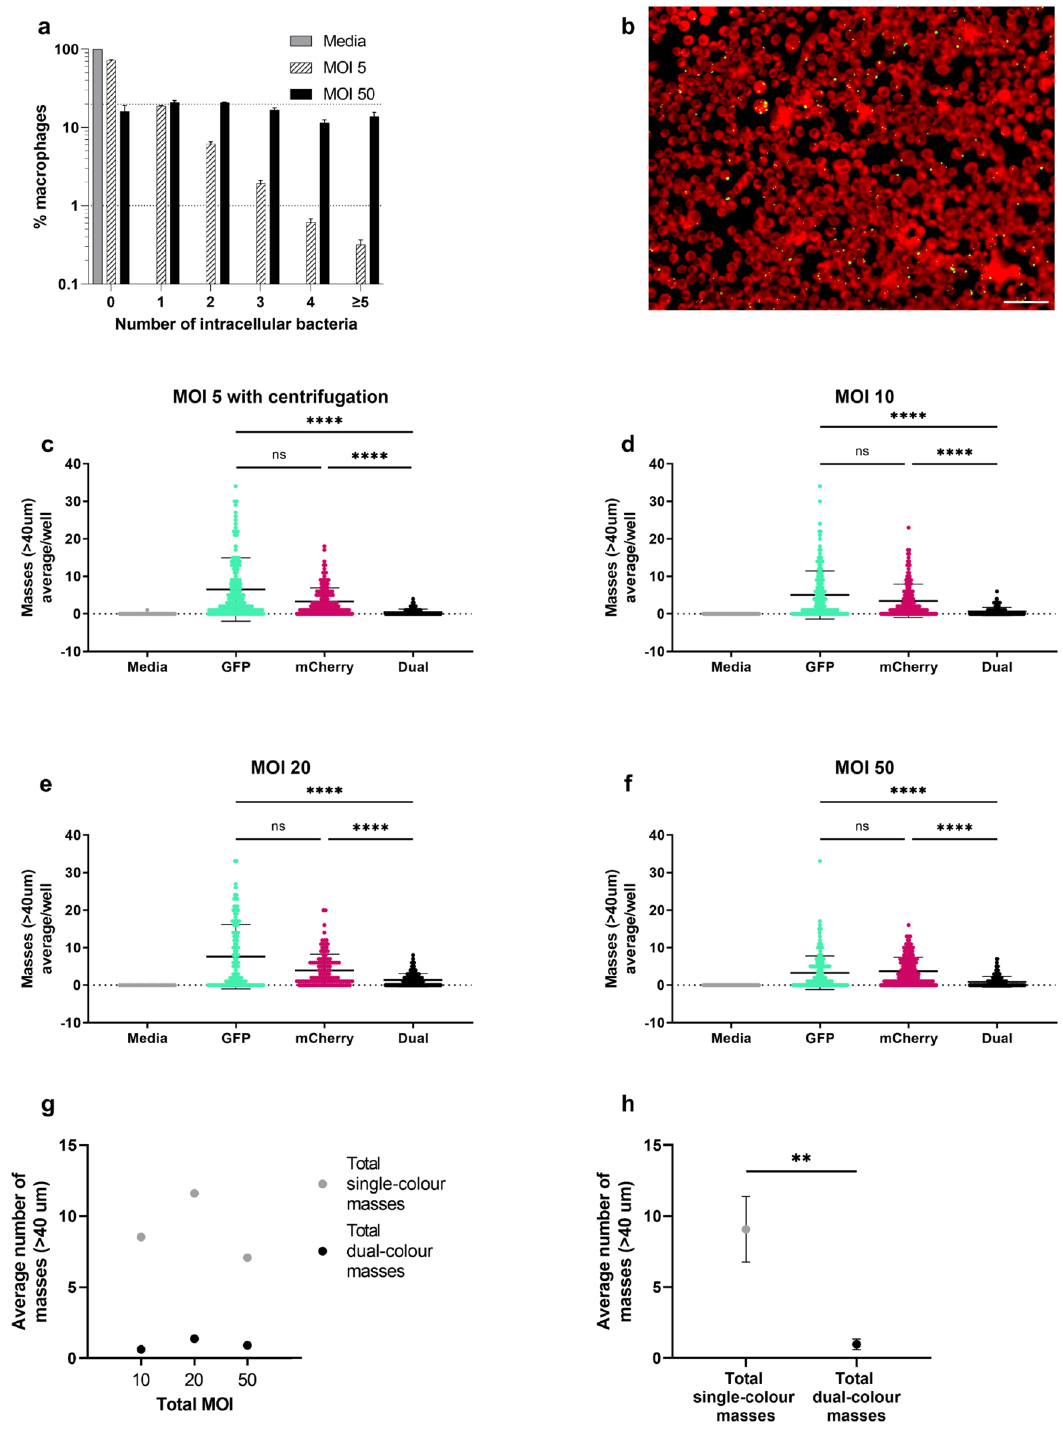
Figure 3. Numbers of bacterial masses does not scale with MOI. ( a ) Percentage (%) of RAW264.7 macrophages with internalised bacteria. Media (grey bars), S. aureus MOI 5 (shaded bars) or MOI 50 (black bars) was added to macrophages, centrifuged onto cells and incubated until 2.5 h post-infection, bars represent mean percentage ± SEM, with dotted lines showing 1% and 20% ( n = 4). ( b ) representative image of RAW264.7 macrophages (red) with internalised bacteria after GFP S. aureus (green) were centrifuged onto cells and incubated for 2.5 h at MOI 5, (scale bar 50 µm). ( c – f ), RAW264.7 macrophages were infected with GFP and mCherry S. aureus in a 1:1 ratio with a total MOI as designated. The number of single- or dual-colour bacterial masses detected at 25 h post- infection is indicated, showing mean values ± standard deviation; ( c ) S. aureus (MOI = 5) was centrifuged onto cells before incubation ( n = 4); ( d ) MOI = 10 ( n = 4); ( e ) MOI = 20 ( n = 3); ( f ) MOI = 50 ( n = 5), GFP (cyan), mCherry (magenta), media control (grey), dual (black) Cells in d-f were uncentrifuged. ( g – h ), Comparison between number of total single-colour (grey) and dual-colour masses (black) for ratio data presented in ( d – f ); ( g ) summary of average plots for ( d – f ); ( h ) total single-colour and dual-colour masses were combined from ( d – f ), data are presented as mean ± standard deviation, ** p < 0.005, **** p < 0.0001, as determined by Kruskal–Wallis test with Dunn’s post-hoc test for panels ( d – g ) or two-tailed Mann–Whitney test for panel ( i